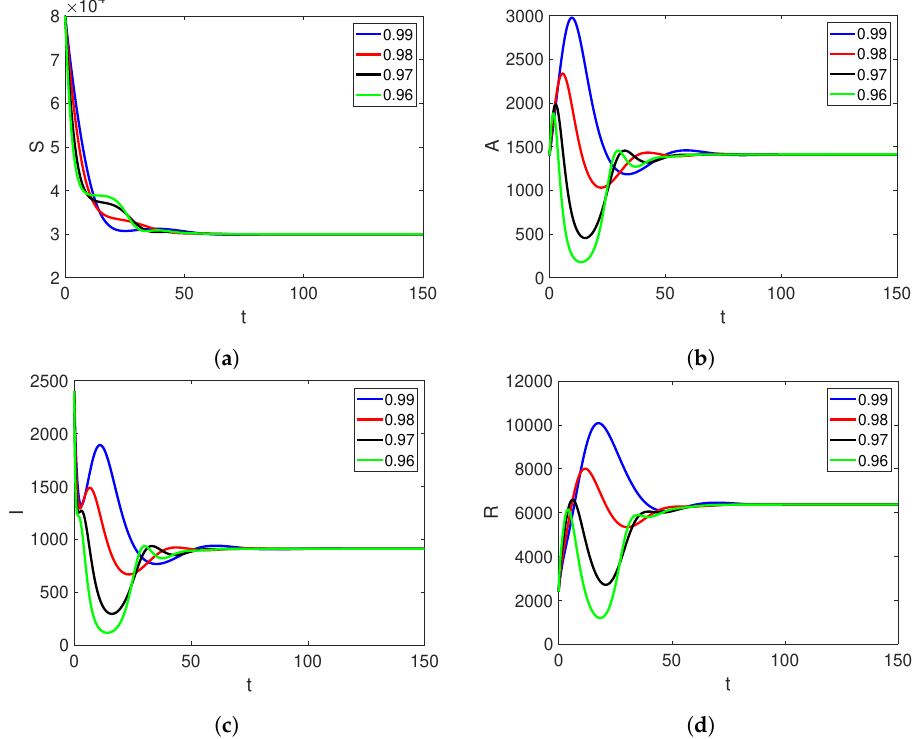
Figure 1. The dynamics of the state variables’ SAIR in model (2) with different fractional orders α vs. time t with initial